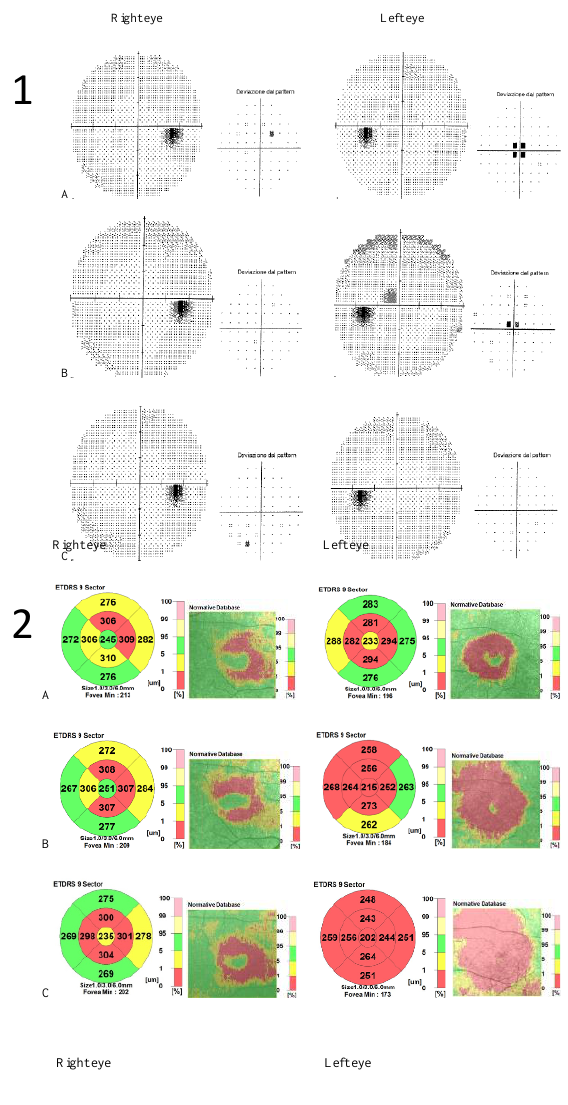
3 Figure 3. Cont